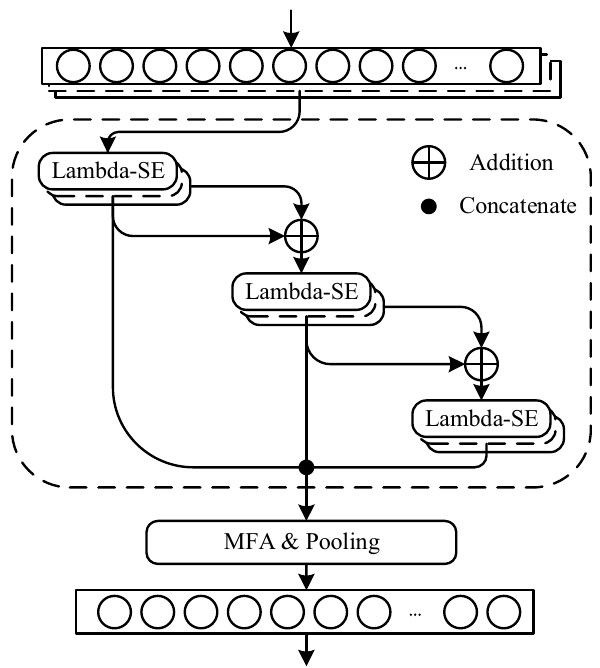
Figure 2. Graphic illustration of Lambda-vector. Multi-layer rectangles represent frame-level features. Single- layer rectangle represents segment-level features. The dashed rectangle represents the extraction process of frame-level